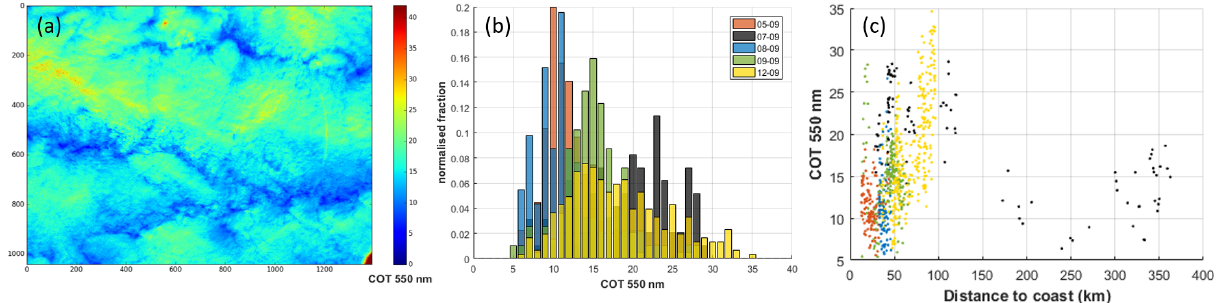
Figure 11. (a) Full OSIRIS image cloud optical depth at 550nm retrieved on 7 September at 09:37UTC from OSIRIS measurements. (b) COT histogram for the five selected flights. (c) Relation between COT and the distance from the measurement to the coastline.